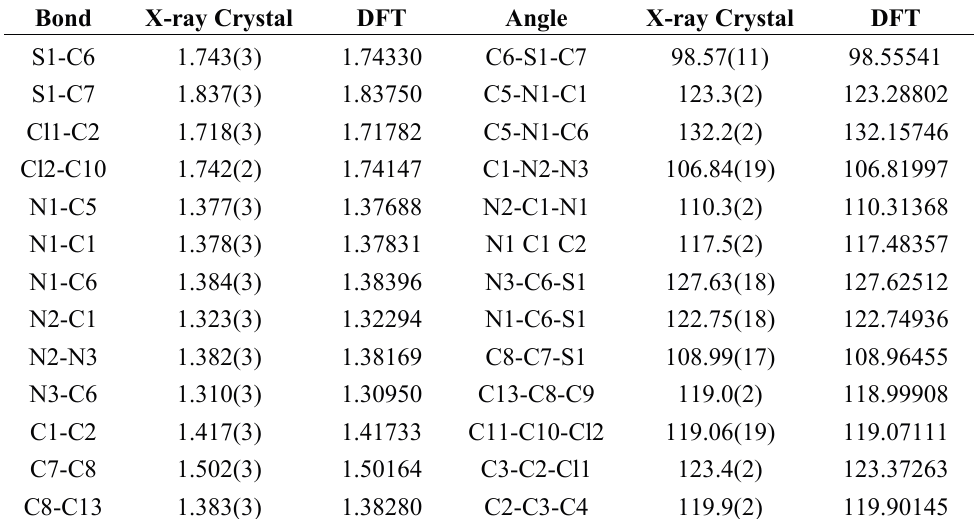
Table 2. Selected bond lengths [Å], angles [°] and theoretical calculations for the title compound. Bond X-ray Crystal